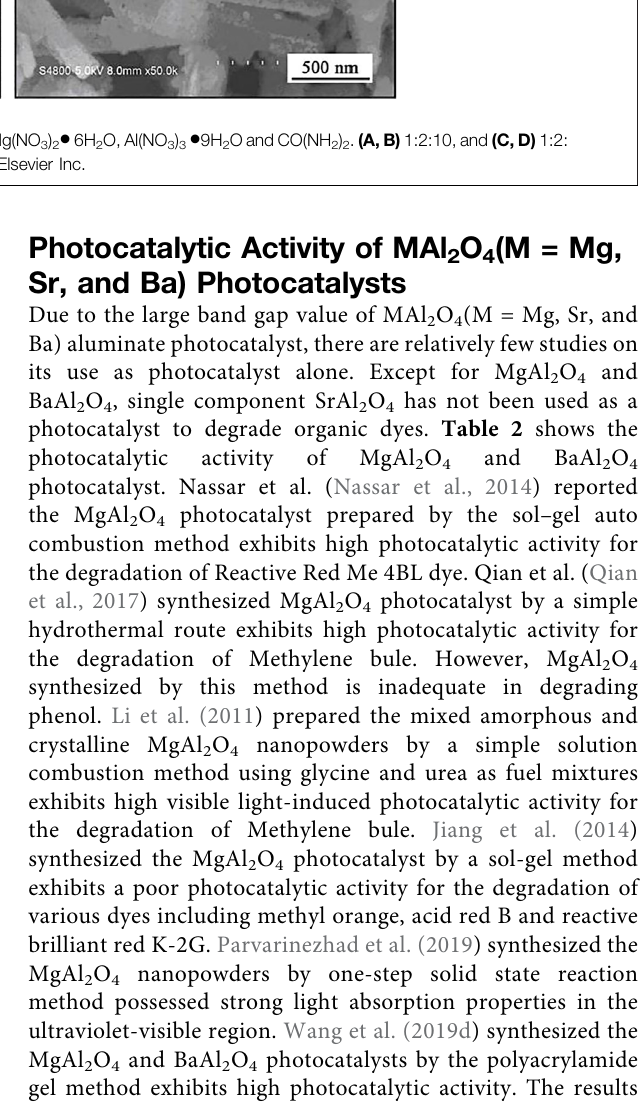
Frontiers in Materials |